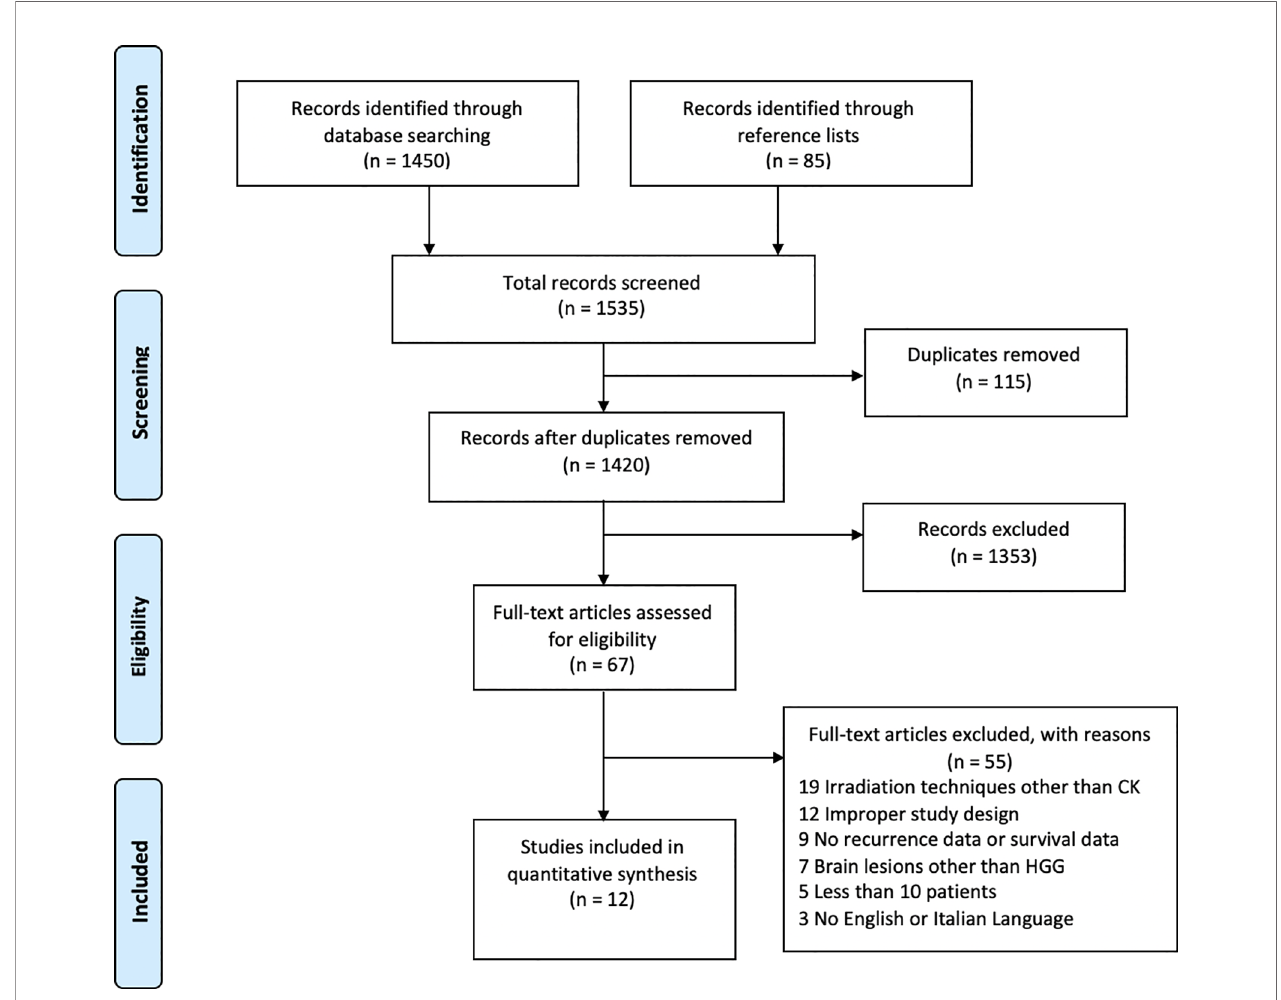
FIGURE 1 | PRISMA fl ow-diagram depicting the literature search